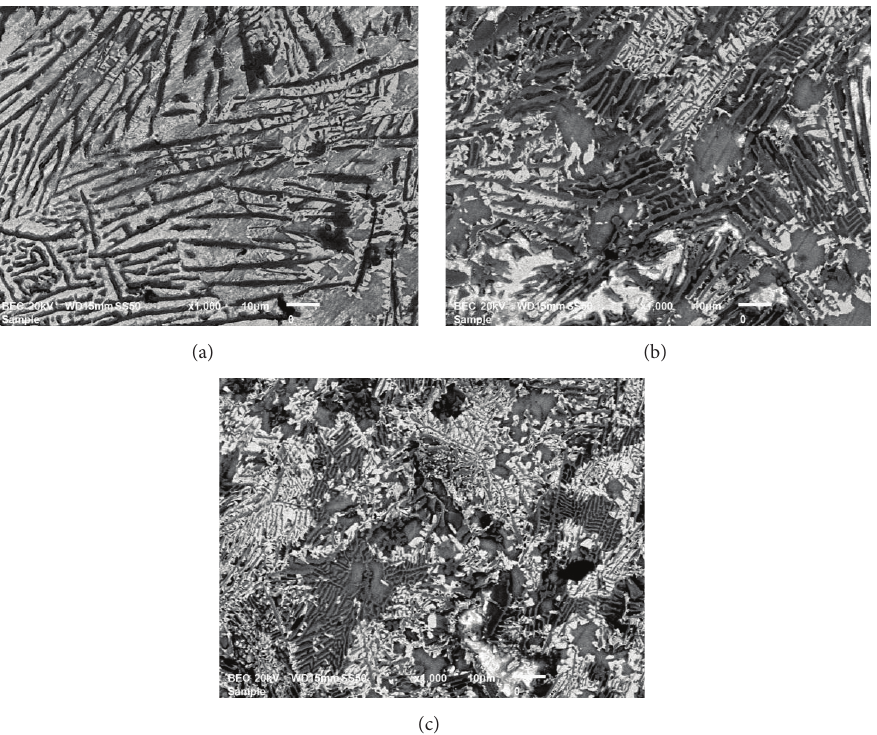
Figure 7: Scanning electron micrographs according to position of as-cast U–Zr–Mn fuel slug prepared in test 𝑒 : (a) lower region, (b) middle region, and (c) upper